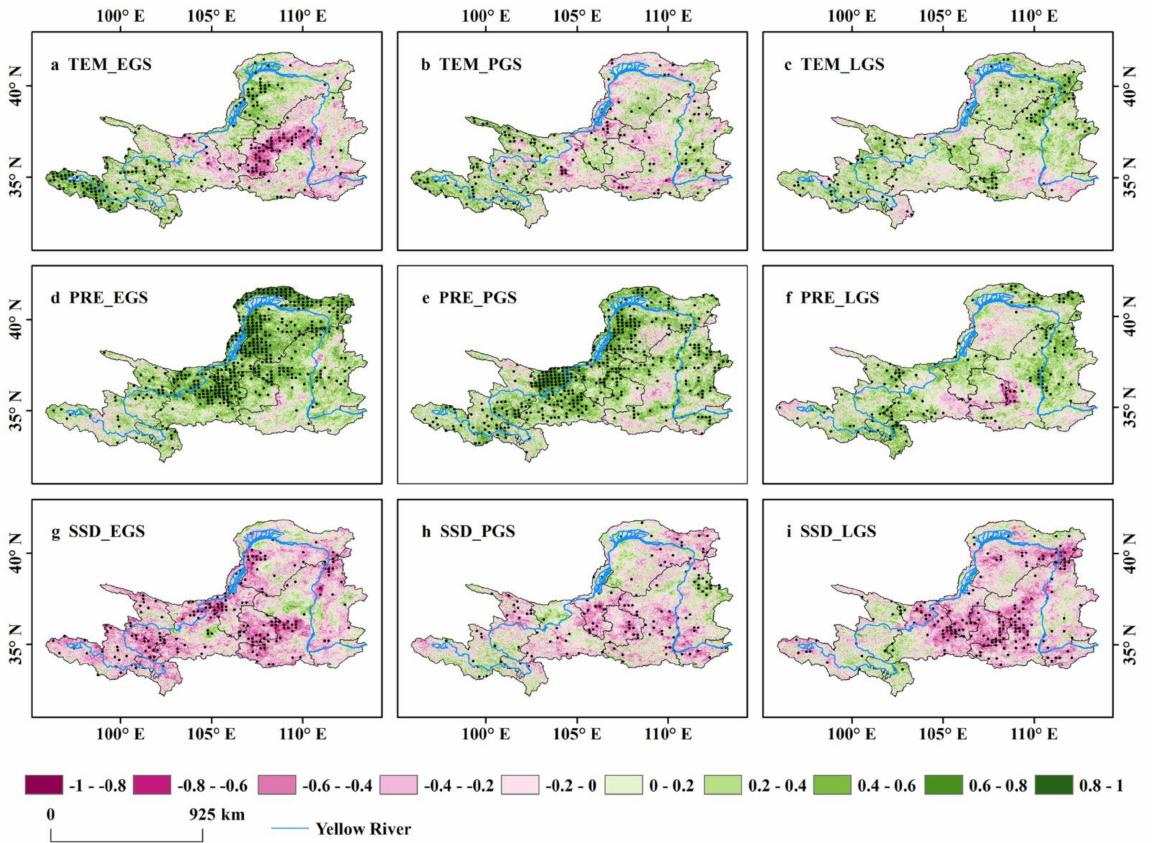
Figure 5. Spatial distribution of the partial correlations between NDVI of each season and the concurrent climate factors. Correlation patterns are shown for EGS ( a , d , g ), PGS ( b , e , h ), and LGS ( c , f , i ), and for correlation with concurrent TEM ( a – c ), PRE ( d – f ), and SSD ( g – i